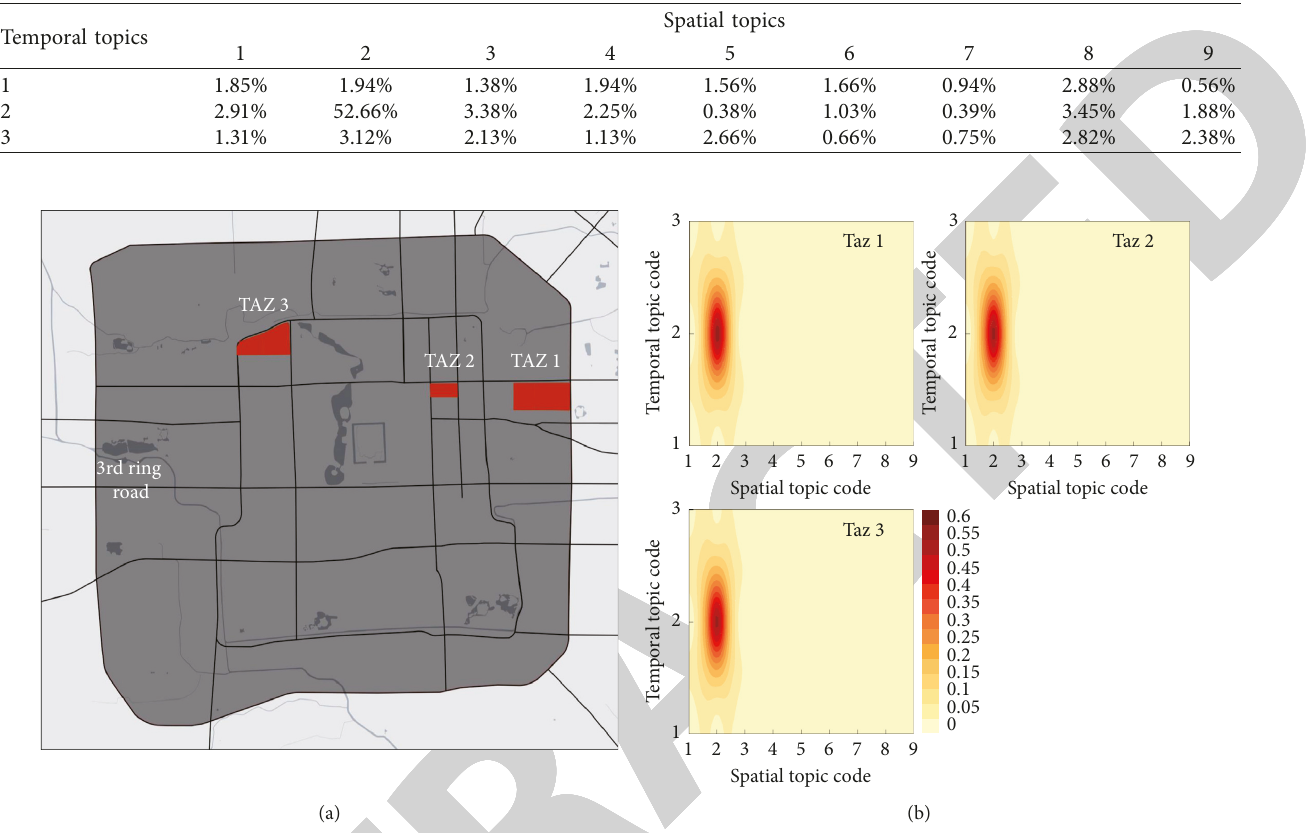
Table 4: Combined spatiotemporal topics of an example TAZ.